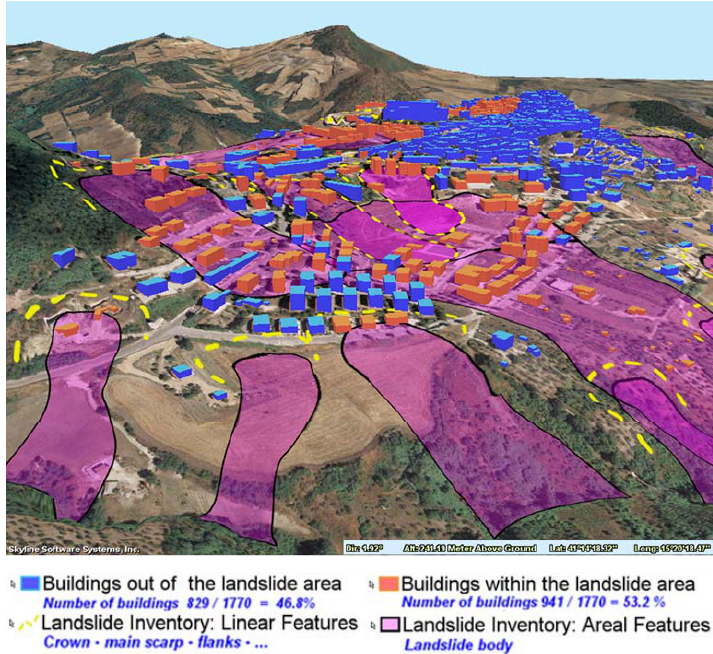
Figure 6. Representation of the vector landslide inventory of an area enclosing the 2 municipality of Bovino (FG). Buildings located within the mapped landslide are highlighted 3 by means of a spatial query in G.I.S. and coloured in red. 4